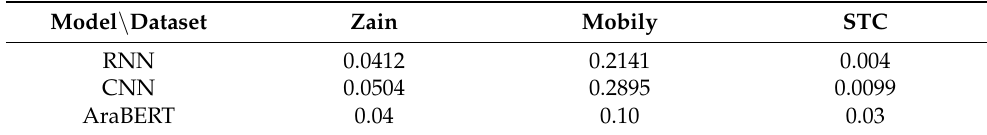
Table 9. Validation loss results obtained by CNN, RNN, and AraBERT.